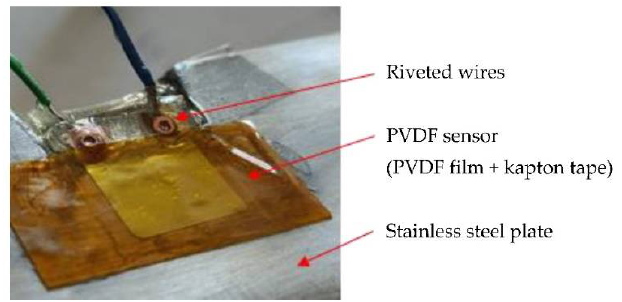
Figure 5. PVDF sensor mounted on stainless steel plate.